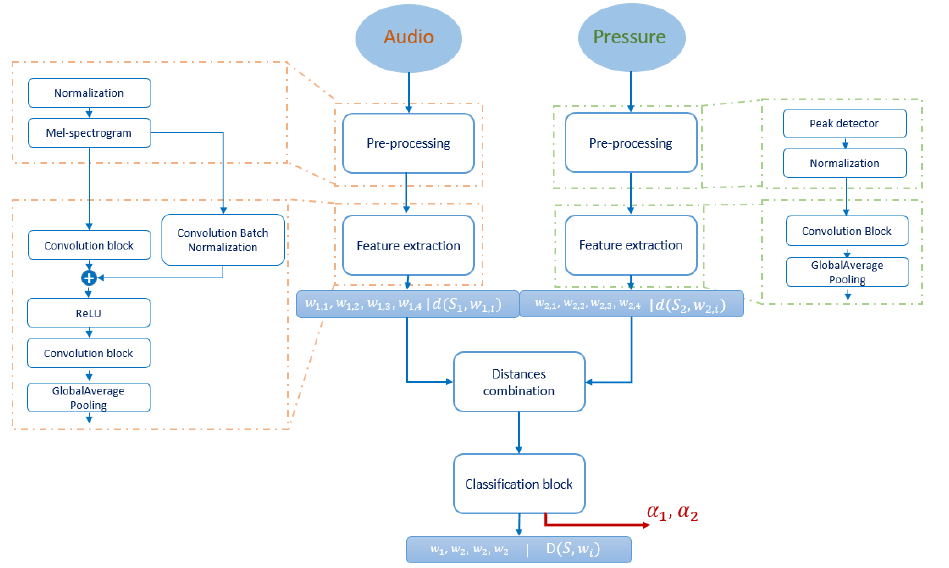
Figure 5. Audio/pressure fusion system for four events classification (open door, close door, glass break, other events) based on prototype learning procedure, and for sensors’ contribution